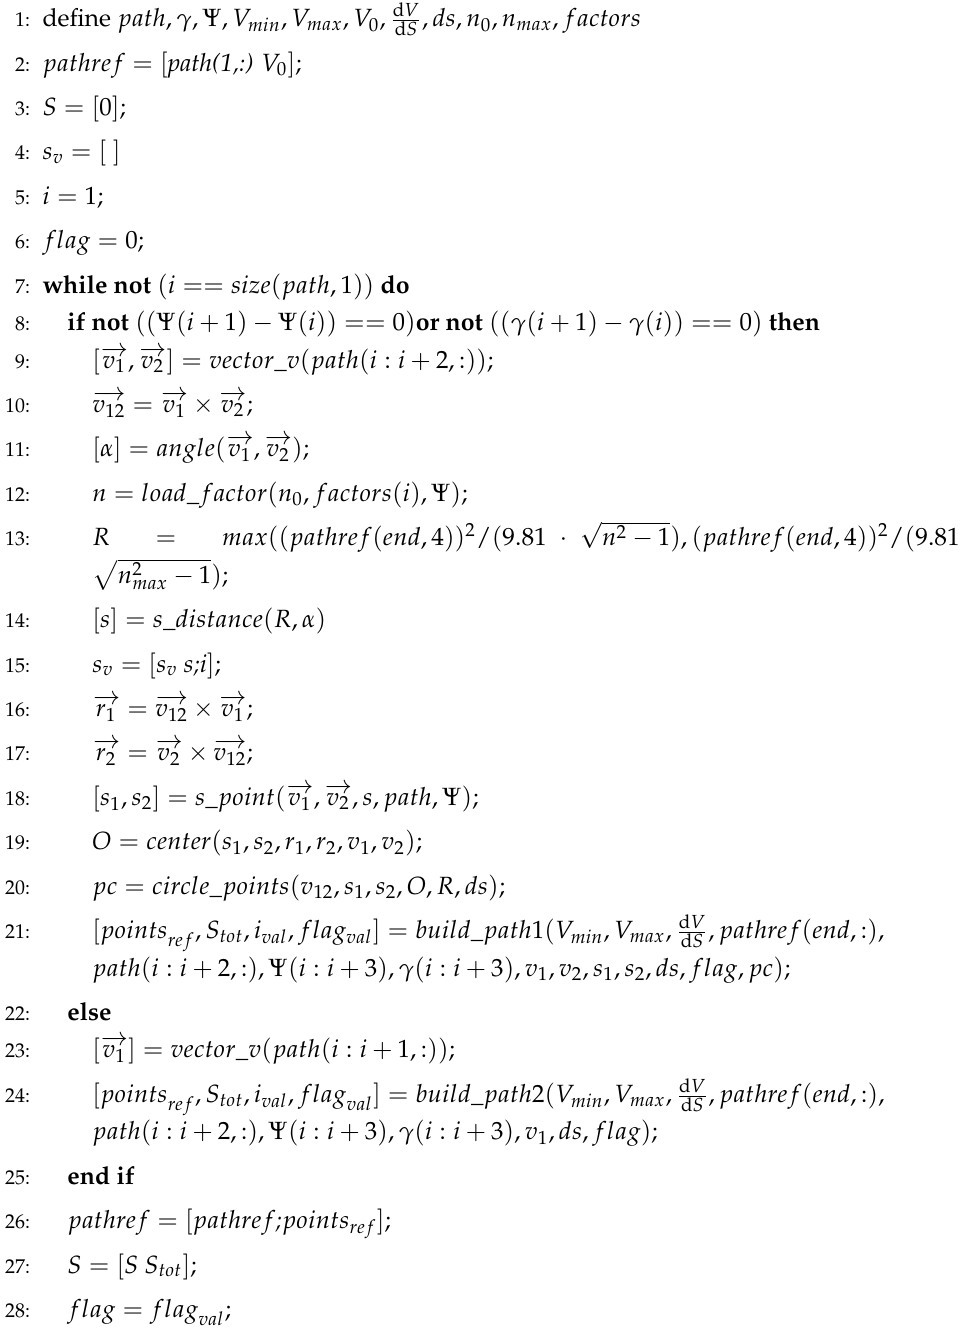
Algorithm 3 Smooth 3D path simple design